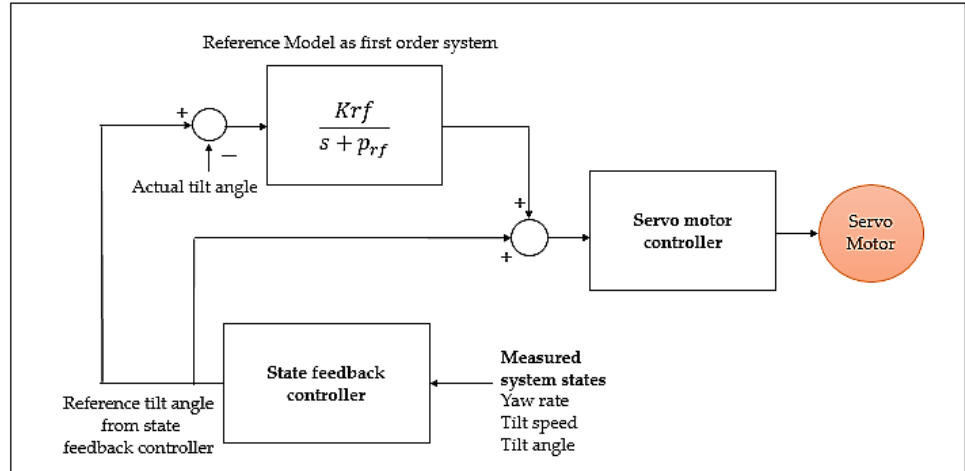
Figure 6. Proposed control loop configuration of state feedback control including the reference model and servo motor control.